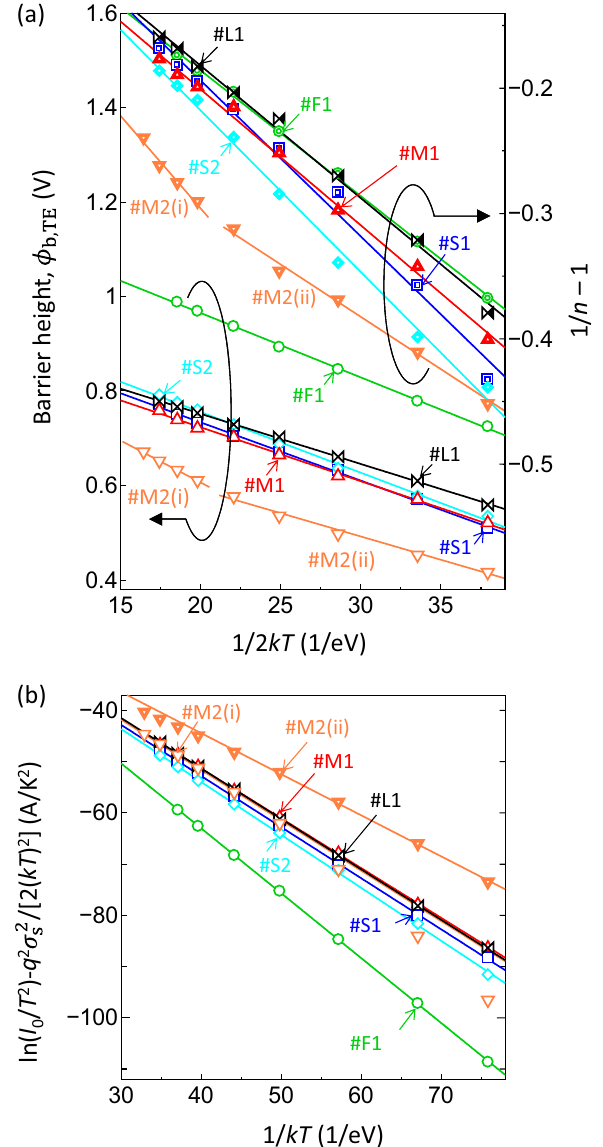
1 vs. 1 / 2 kT plots and ( b ) modified Richardson plots based on the barrier Figure 5. ( a ) φ b,TE and 1 / n − inhomogeneity model and the forward J-V-T characteristics for the #F1, #S1, #S2, #M1, #M2 and #L1 pits. Solid lines indicate the best fit to each